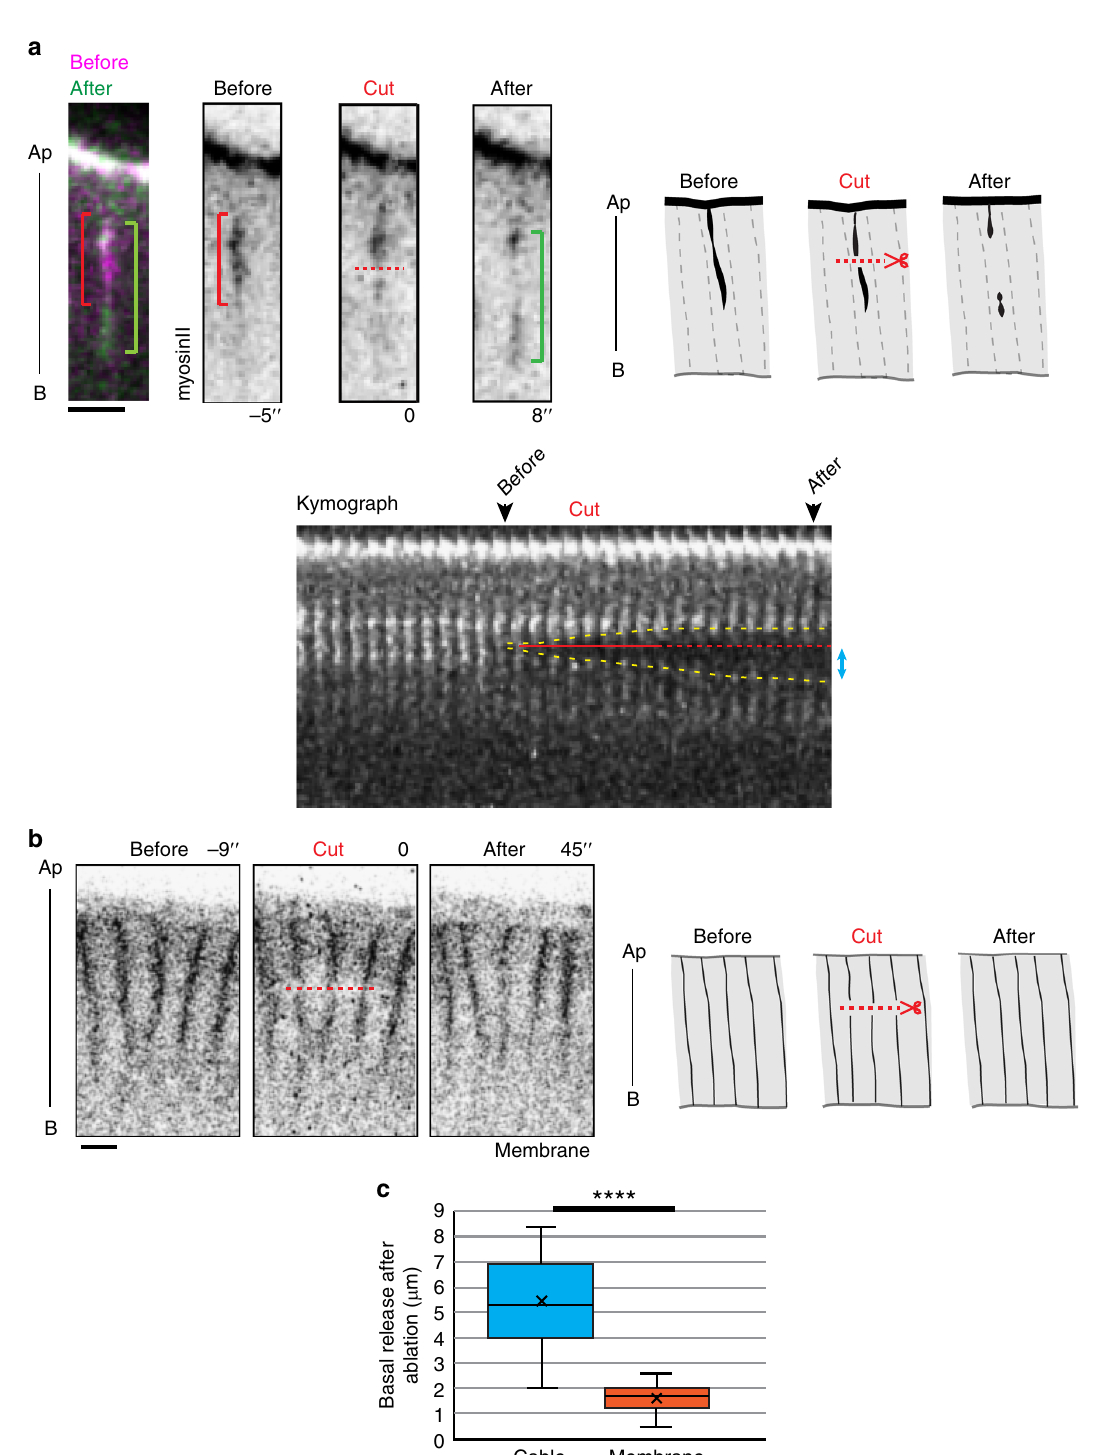
Fig. 5 Apico-basal cables formed in mesoderm cells are under tension. a Laser ablation of apico-basal myosin cable. (top) Images extracted from a movie and corresponding schemes showing transversal views of a KI-sqh::GFP embryo mesoderm cells showing a myosin cable before (red bracket), during and after (green bracket) laser cut (red dotted line). In the kymograph (bottom), the timing of laser cut is indicated by the red line, prolonged by a dotted red line to visualize the site of ablation, and the cable release highlighted by yellow dotted line. Blue arrows indicate the basal release. Scale bar: 5 µ m. b Control laser ablation of lateral membranes of the embryo (resille::GFP line). Images extracted from a movie and corresponding schemes showing transversal views of the epithelium before, during and after laser ablation. The laser cut is indicated with a red dotted line. Note that the fl uorescence at the membranes appear to recover rapidly. Scale bar: 5 µ m. c Curves of the average recoil observed between the region of ablation and the remaining cable (as shown by the blue arrow in the kymograph) or the remaining membrane. Statistical signi fi cance was assessed by the Wilcoxon signed-rank test (control cut (membrane): n = 11 embryos; apico-basal cable cut: n = 11 embryos; p < 0.0001 — signi fi cant ****). Ap apical, B